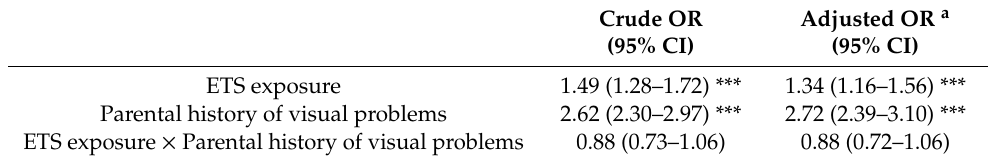
Table 6. The interaction between hereditary factors and pre- and post-natal ETS exposure on astigmatism.